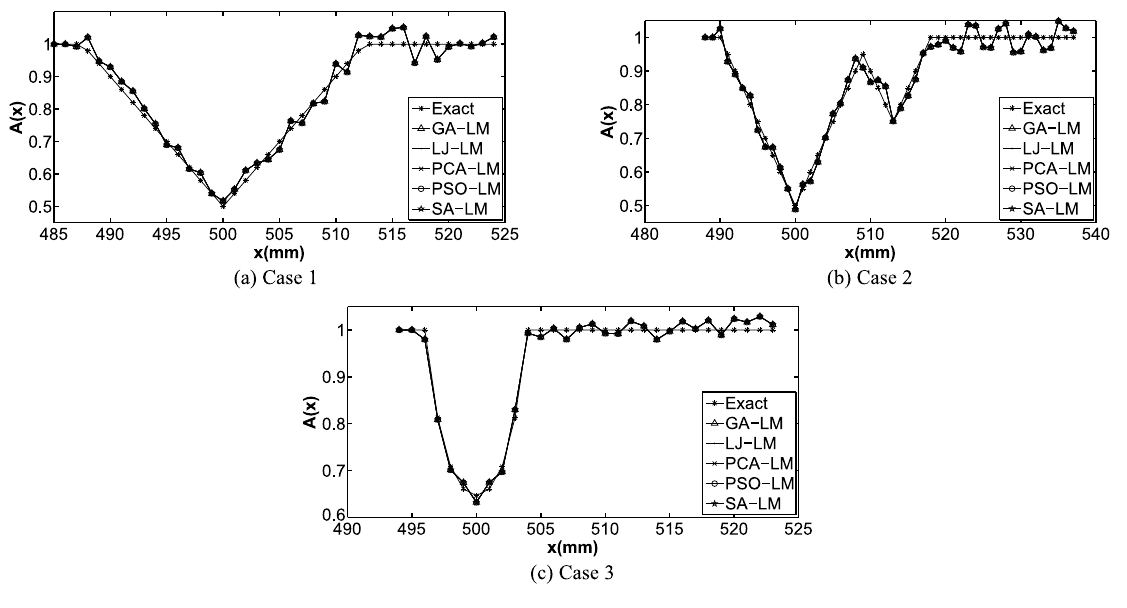
Fig. 7. Damage identification for Cases 1 to 3: Hybrid